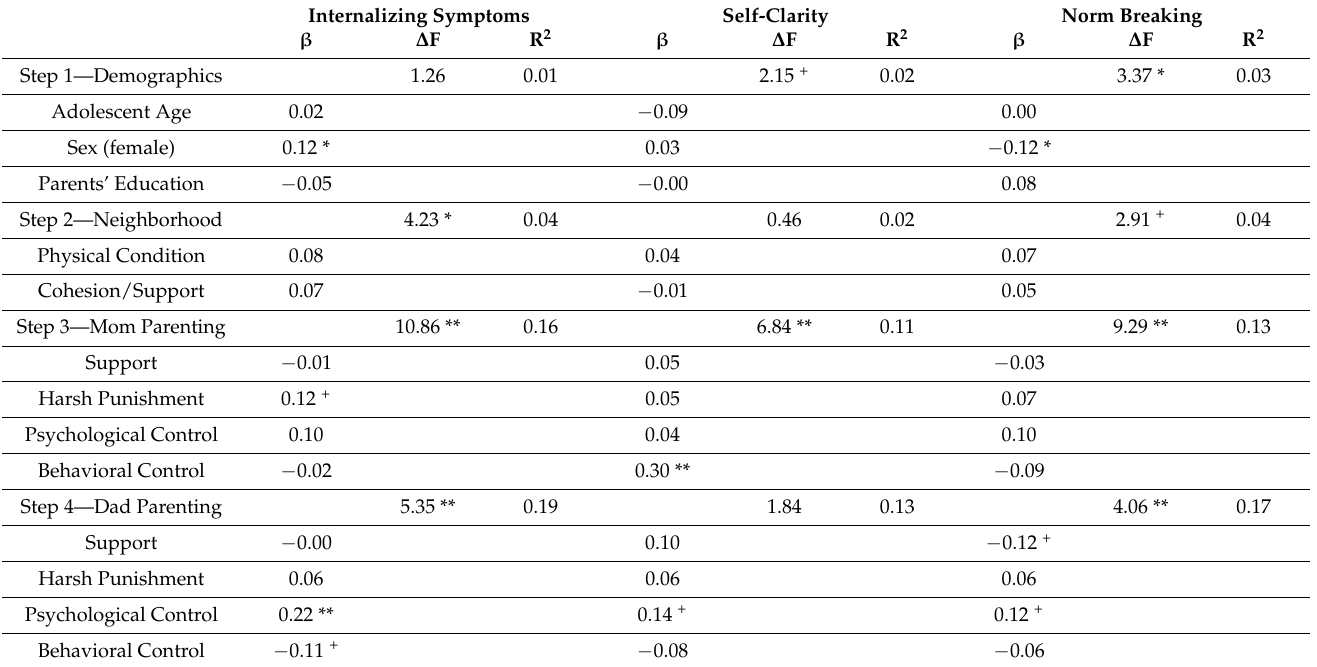
Table 2. Hierarchical regression (final model) of parenting and neighborhood on